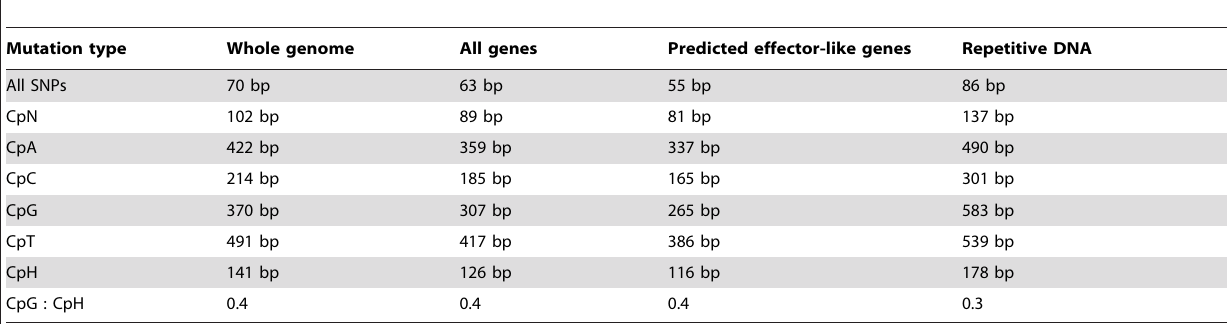
Table 2. The average distance between various types of SNP mutations, within the AG8 genome assembly, genes, predicted ‘effector-like’ genes and repetitive DNA.